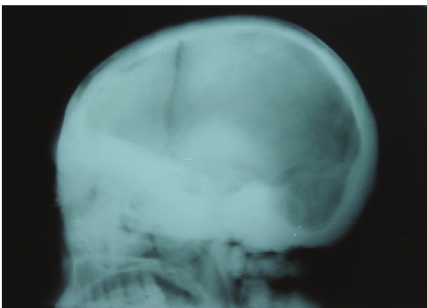
Figure 2: Lateral skull view showing thickening of the inner and outer cortical tables and widening of the diploic space.